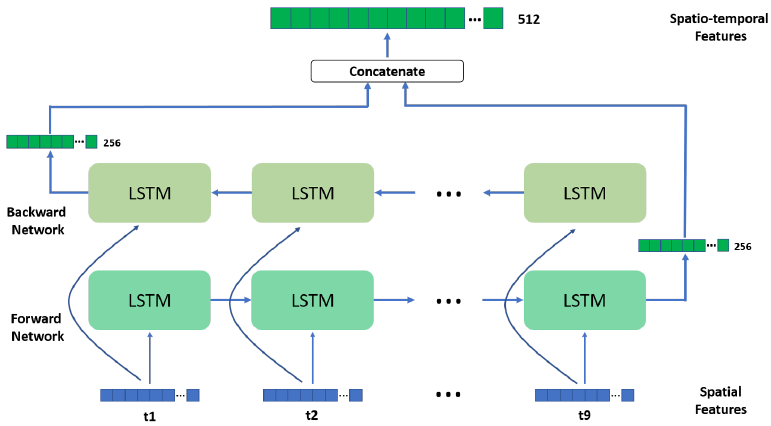
Figure 5. Illustration of the temporal feature extraction module, using a BiLSTM